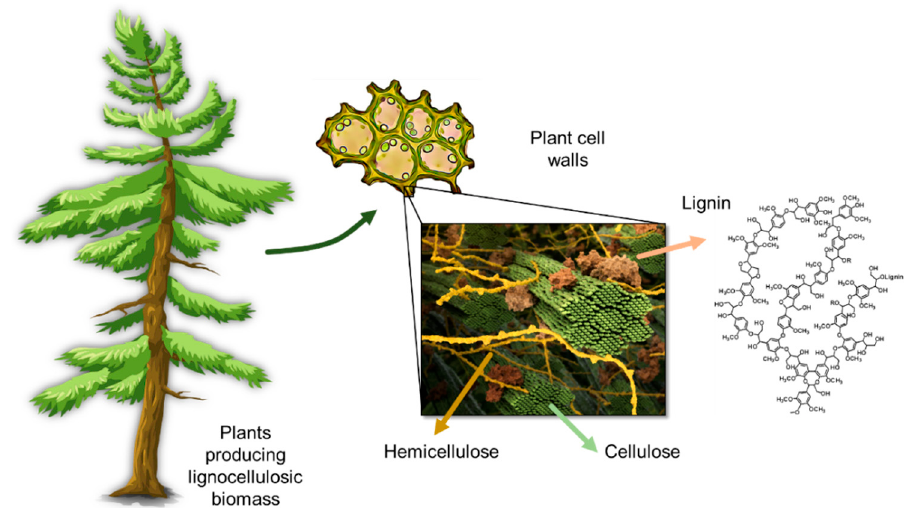
Figure 1. Schematic representation of the lignin location and structure in plants. Part of the image was kindly provided by scistyle.com and Jeremy C. Smith et al. UT/Oak Ridge National Laboratory Center for Molecular Biophysics.